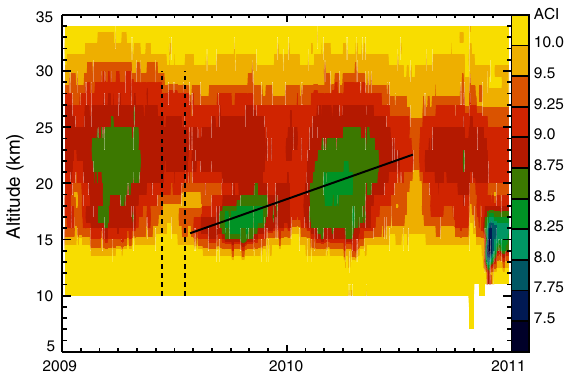
Figure 13. MIPAS 9-day running median of aerosol cloud index (ACI) between 10 ◦ N and 10 ◦ S from 2009 to 2010, overlaid with ascent speed of the water vapor tape recorder (solid line) derived from the Aura Microwave Limb Sounder (MLS) water vapor mix- ing ratios by Glanville and Birner (2017). Black dashed lines indi- cate 12 June 2009 when the eruption started and 20 July 2009 when the simulations show first substantial aerosol transport to 10 ◦ N– 10 ◦